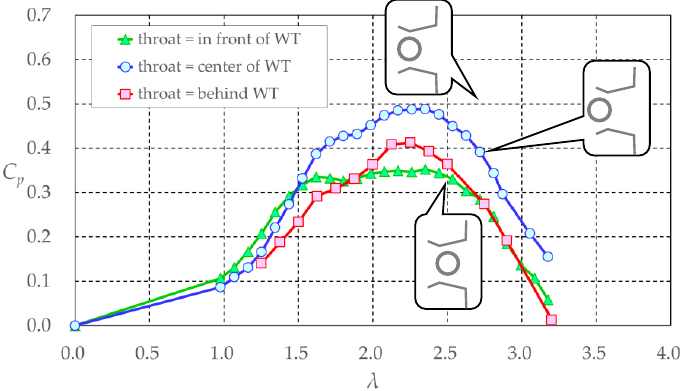
Figure 9. Power coefficient C p of wind turbines vs. tip speed ratio λ (diffuser length, L = 1.14 D m; flange width, h = 0.5 D m; semi-open angle of diffuser, φ = 15°). Refer to Figure 2 for h , D , and L .